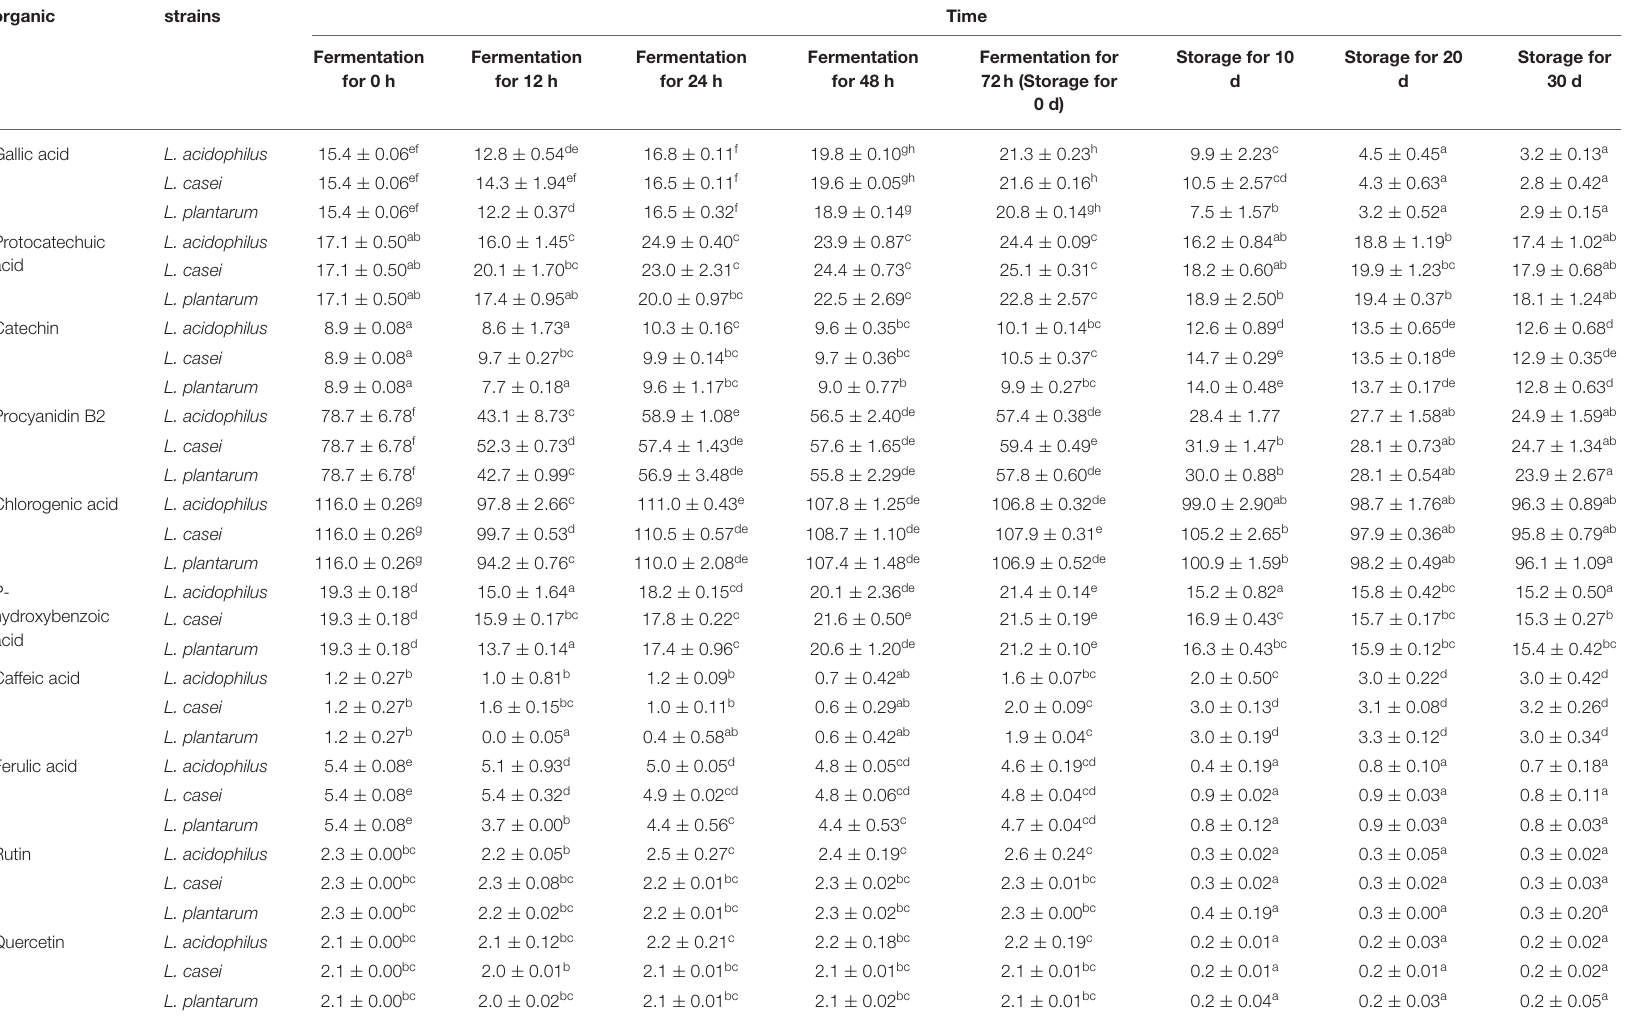
TABLE 2 | Changes in the contents of individual phenolic compounds (mg/L) of apple juices during lactic acid fermentation and the subsequent refrigerated storage period (4 ◦ C, 30 days). organic strains Time Fermentation Fermentation Fermentation for 0 h for 12 h for 24